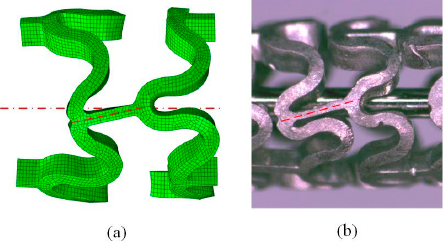
Figure 13. Comparison between ( a ) simulated and ( b ) experimental profiles of crimped Stent A.